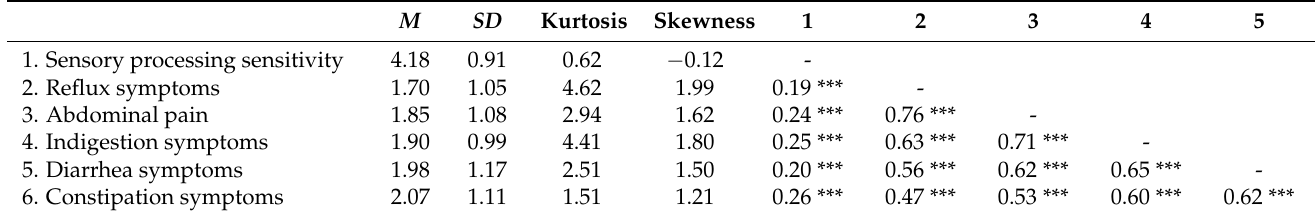
Table 2. Descriptive Statistics and Correlation Coefficients among Variables ( N = 863).